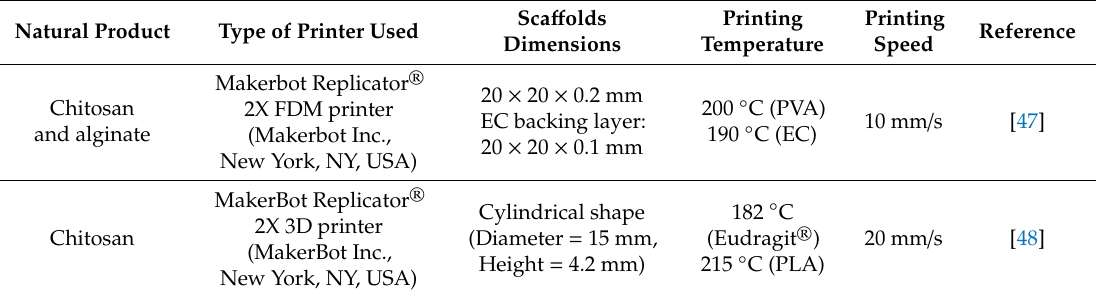
Table 2. Printing conditions and sca ff olds dimensions of FDM 3D printed systems containing natural